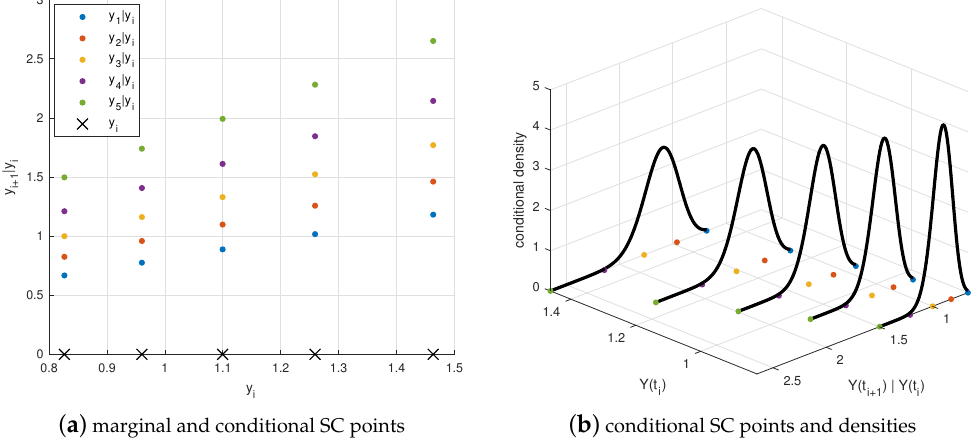
Figure 2. Schematic illustration of matrix C , with five marginal SC points and five conditional SC points. The conditional SC points are dependent on the realization connected to the corresponding marginal SC